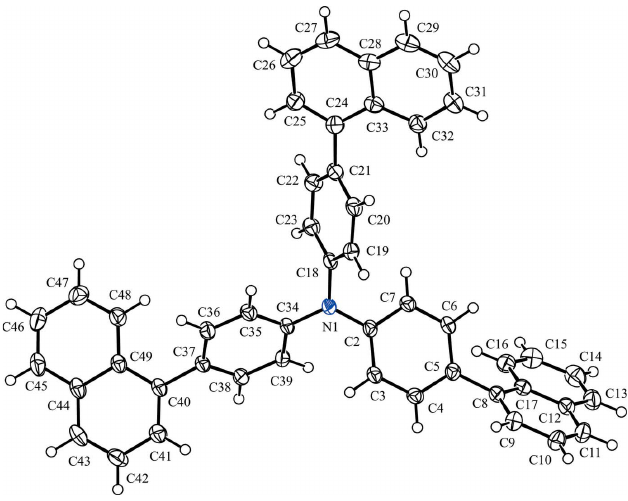
Figure 1 The molecular structure of the title compound, with atom labeling. Displacement ellipsoids are drawn at the 50% probability level. H atoms are represented by spheres of arbitrary radius.